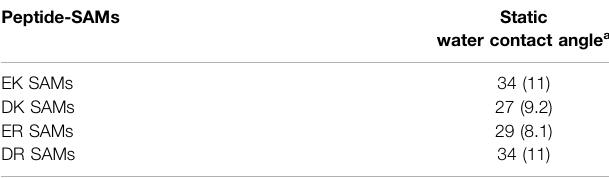
TABLE 4 | Static water contact angles (WCA).